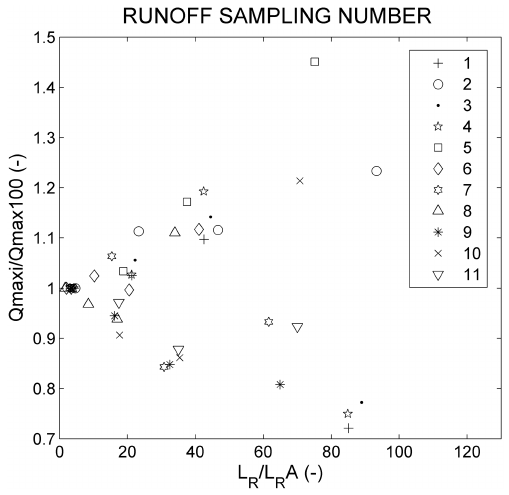
Figure 11. Normalised runoff peaks versus runoff sampling num- ber ( R R / L RA ) : results averaged over each of the 10 subcatchments (numbered 1 to 10) and over the whole catchment (no. 11).